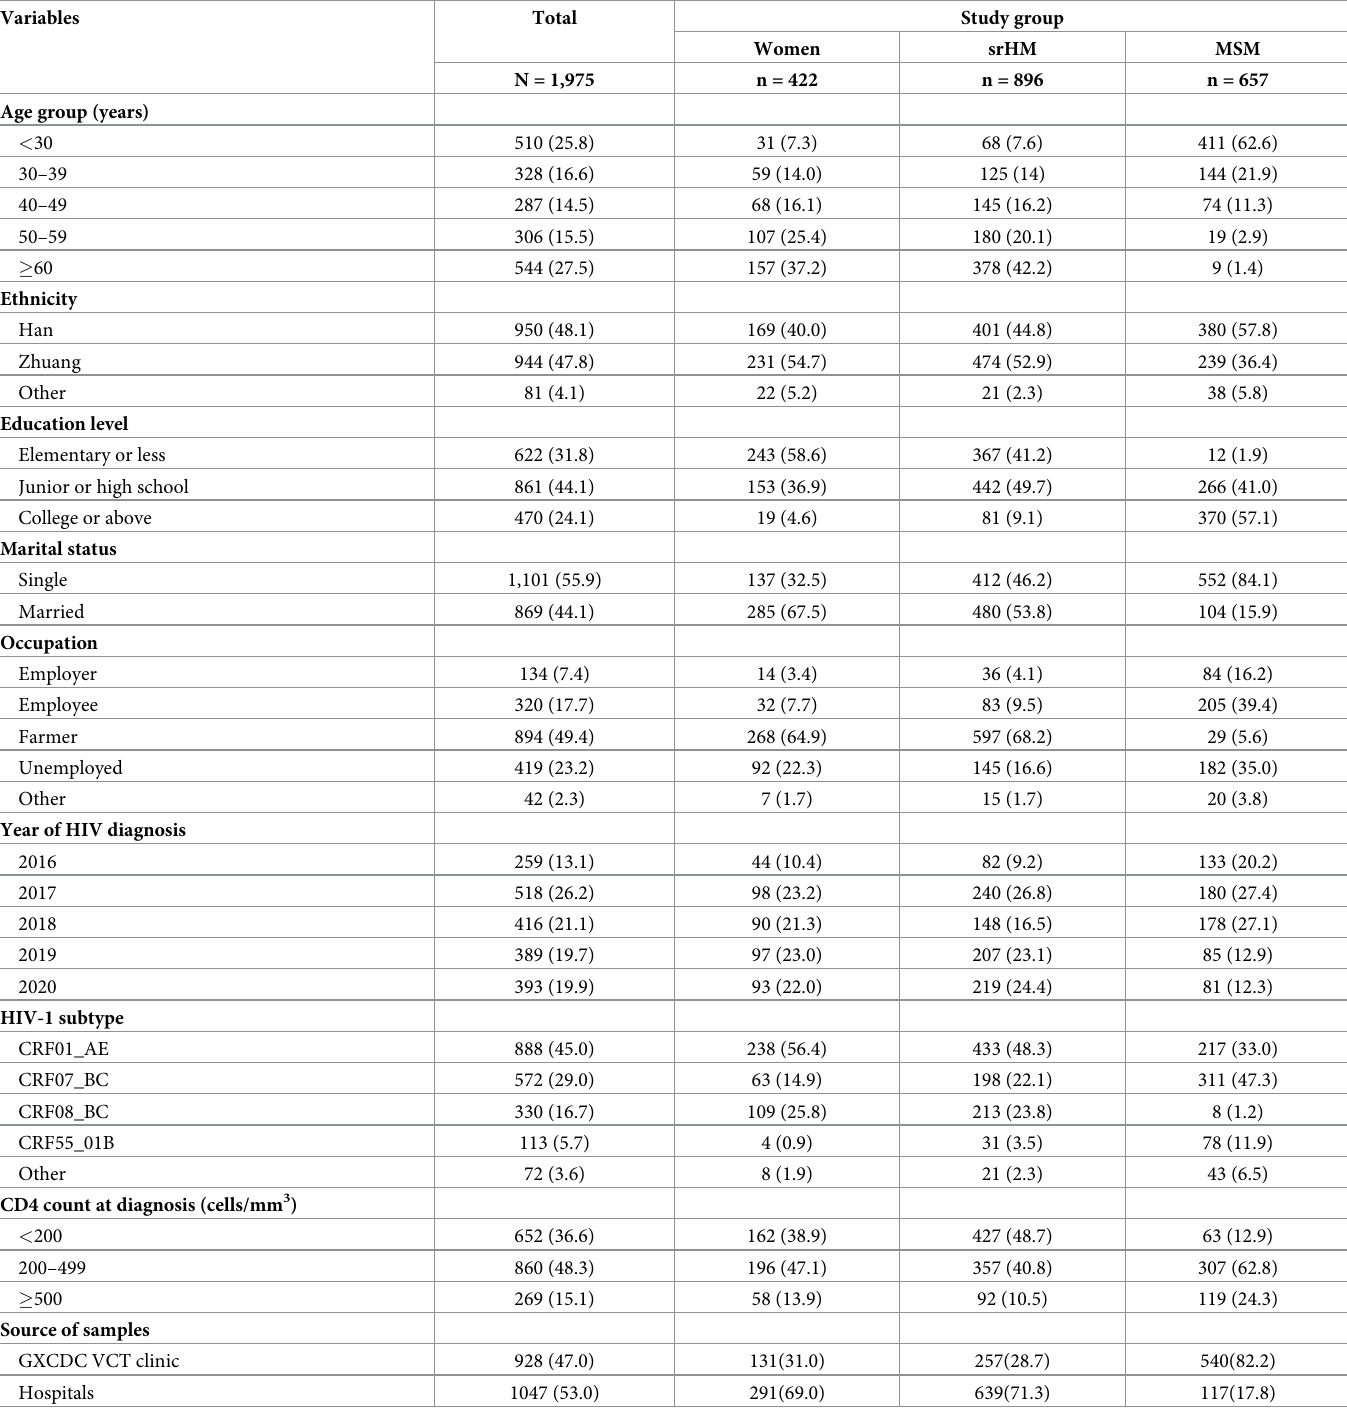
Table 2. Comparison of characteristics among women, self-reported heterosexual men and